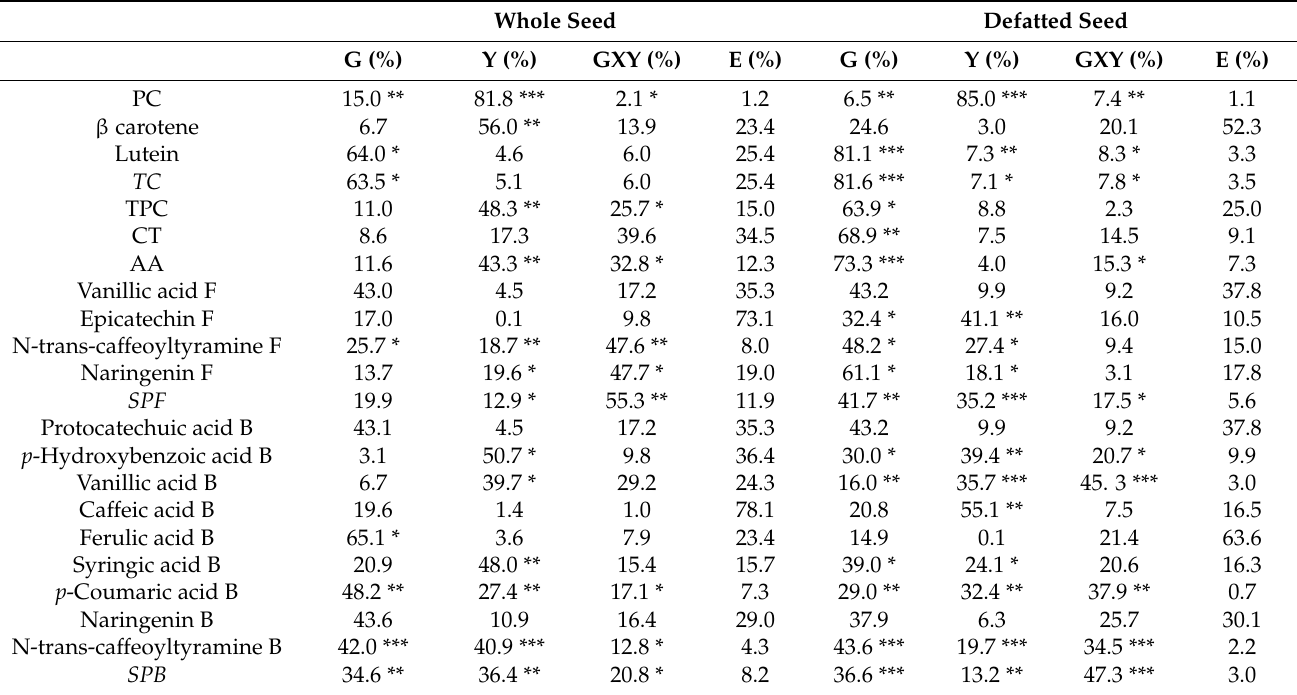
Table 3. Relative weight of the single and combined influences of genotype (G), year (Y), and G × Y